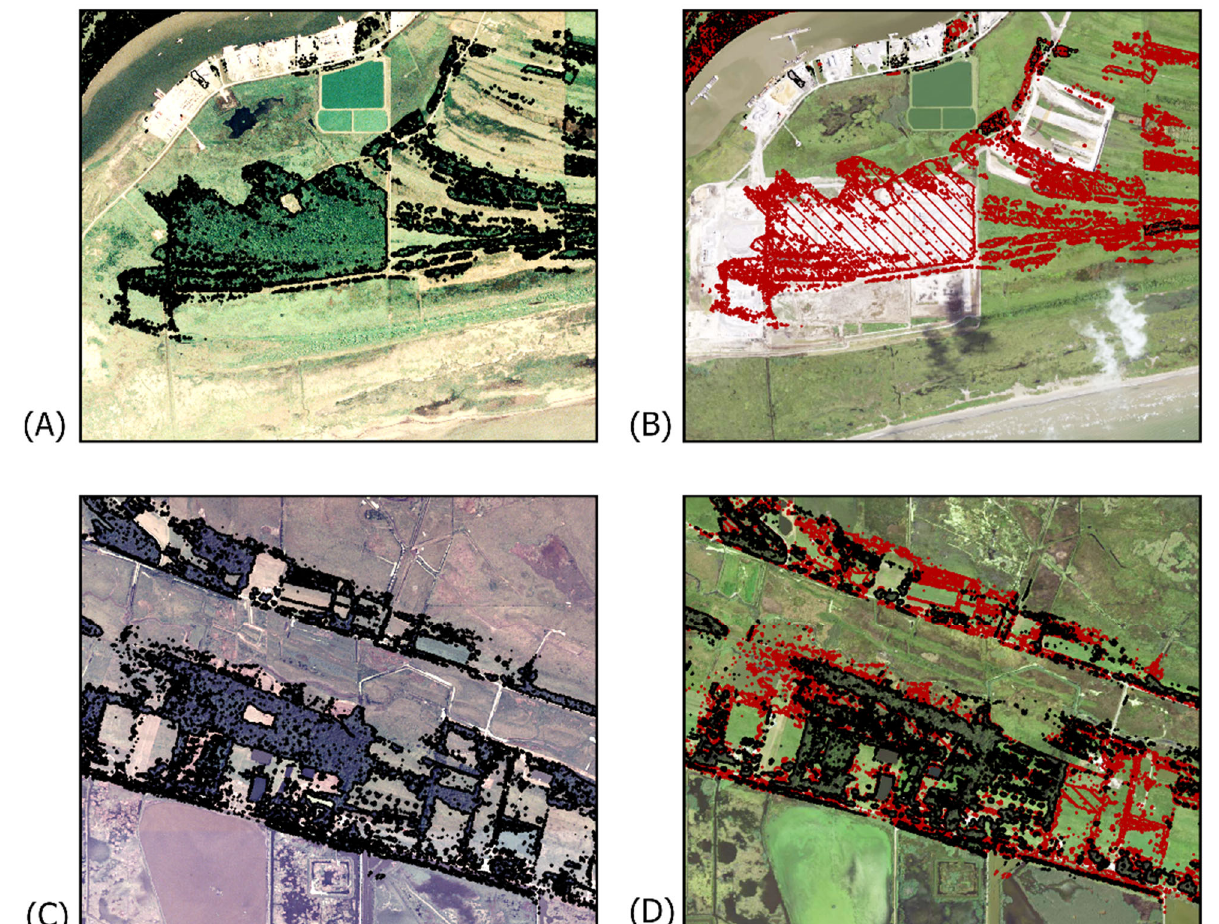
Figure 8. A depiction of clearing for industry in ( A , B ), and a depiction of forest whittling from ( C , D ). The black extent represents the current forest area, red hashed lines indicate a loss. The left panels show 2007 NAIP imagery, while the right are 2019 NAIP imagery.